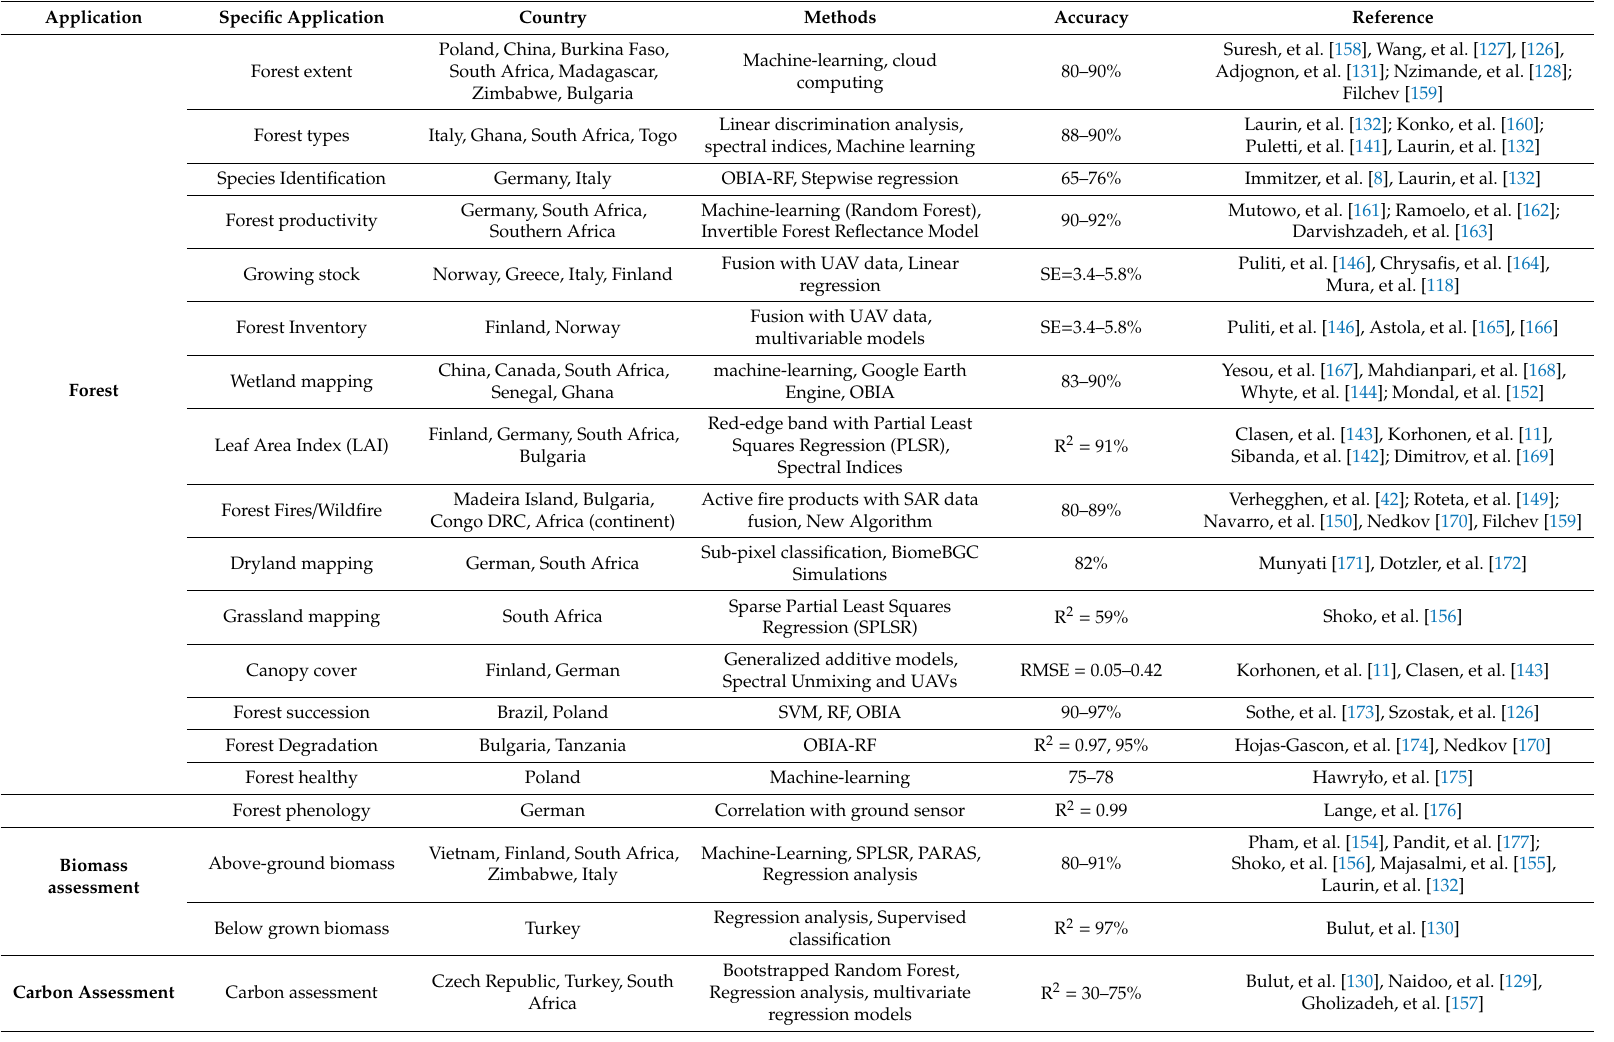
Table 5. Summary of major forest application of Sentinel-2 imagery across the